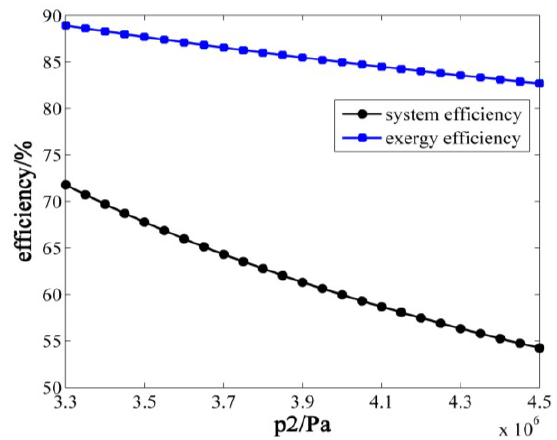
Figure 7. The variation of system efficiency with pressure in the high pressure vessel.